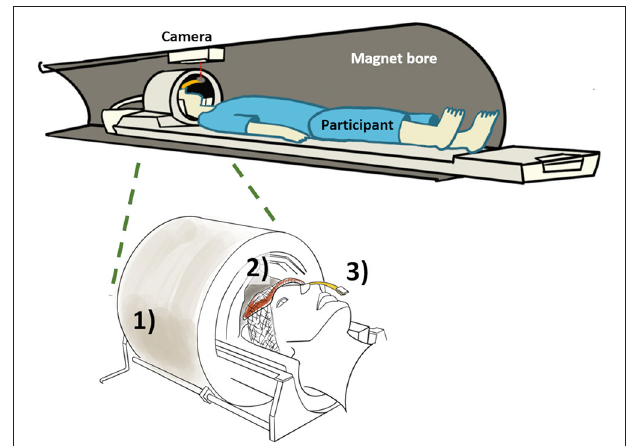
FIGURE 1 | Overview of proposed method with (1) commercial head coil, (2) BaTiO 3 padding on forehead, and (3) holographic optical marker attached to a plastic extension bar and taped to the participant’s nose bridge.